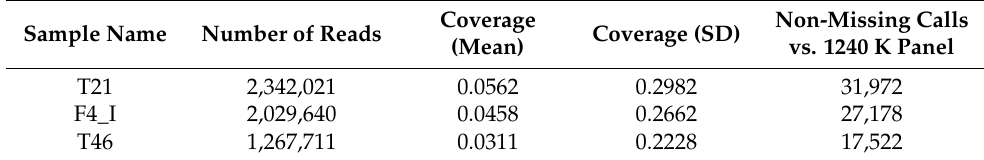
Table 2. Summary table for the individuals suitable for the analyses.